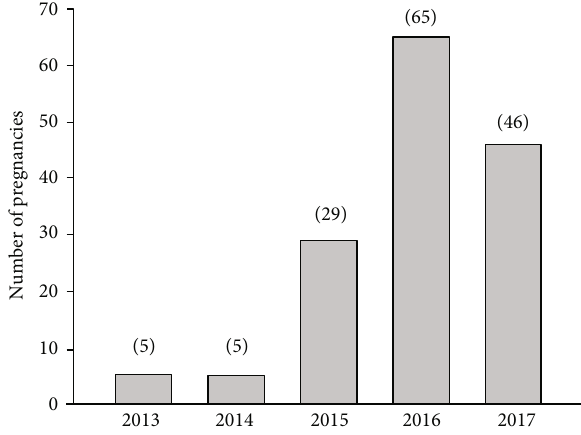
Figure 2: Numerical breakdown of the number of cases in which women developed GDM in their fi rst pregnancy between the years 2013 and 2018 at Mayo Clinic, Rochester, MN. It should be noted that the increase in GDM cases in the fi nal three years of the study can be explained by a change in screening methods for GDM. This indicates that a greater number of patients falling within Groups B, C, D, and E of Figure 1 will be available in future studies carried out over a fi ve-year period.